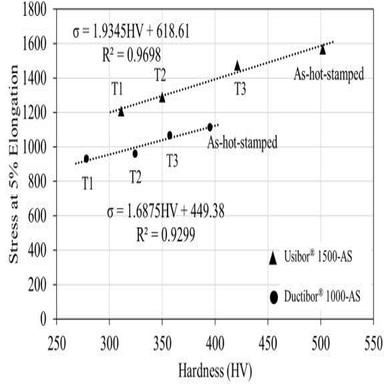
Linear relationship between stress at 5% elongation with hardness for as-hot-stamped and tempered martensitic (HAZ) conditions. As-hot stamped tensile data for Usibor® 1500-AS due to Samadian et al. and for Ductibor® 1000-AS due Lee .